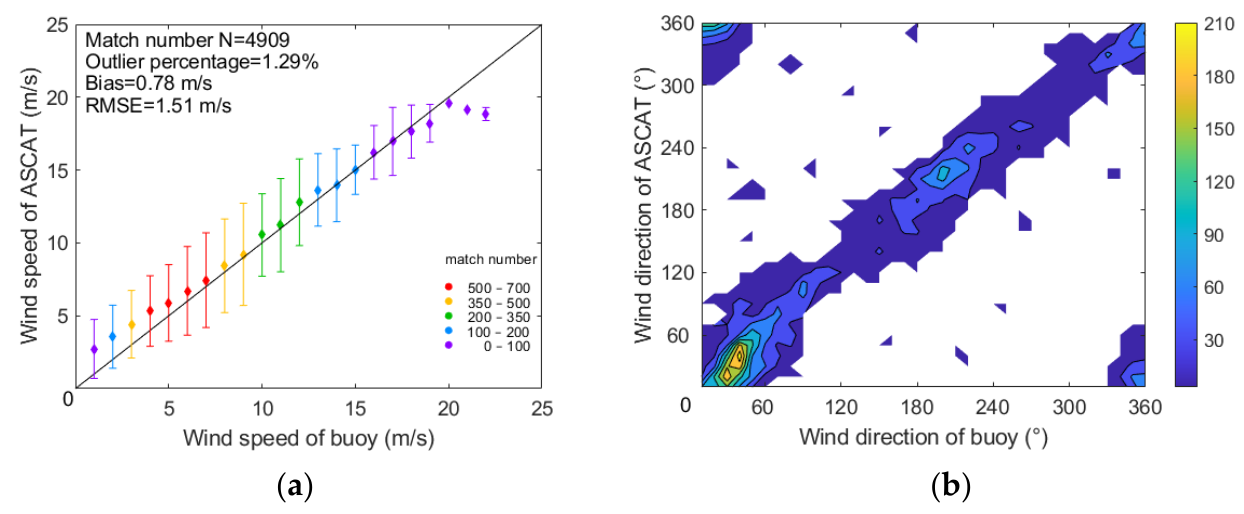
Figure 3. Validation of the ASCAT wind data against measurements of 12 buoys except for buoy 5 in coastal regions of China Seas: ( a ) wind speed and ( b ) wind direction. The colors denote the match number of the collocated data.